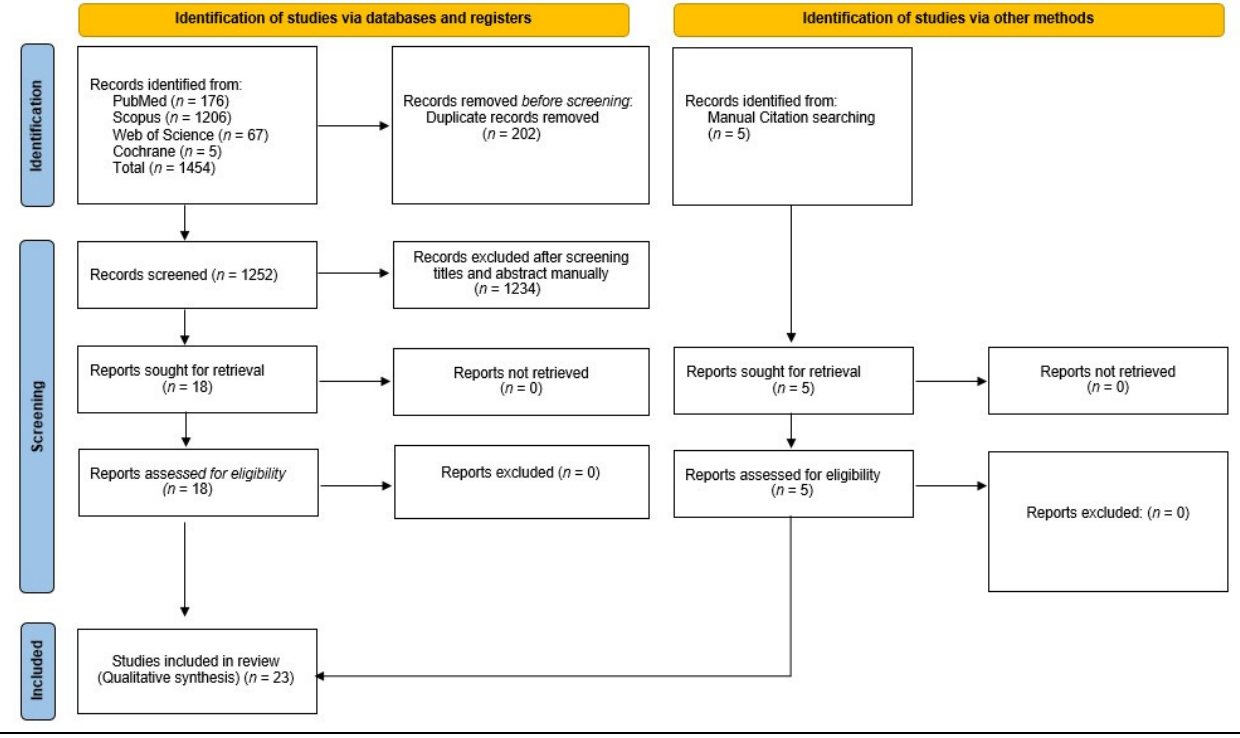
Figure 1. PRISMA flow-chart demonstrating the article selection strategy, preferred reporting items for systematic reviews and meta-analyses.